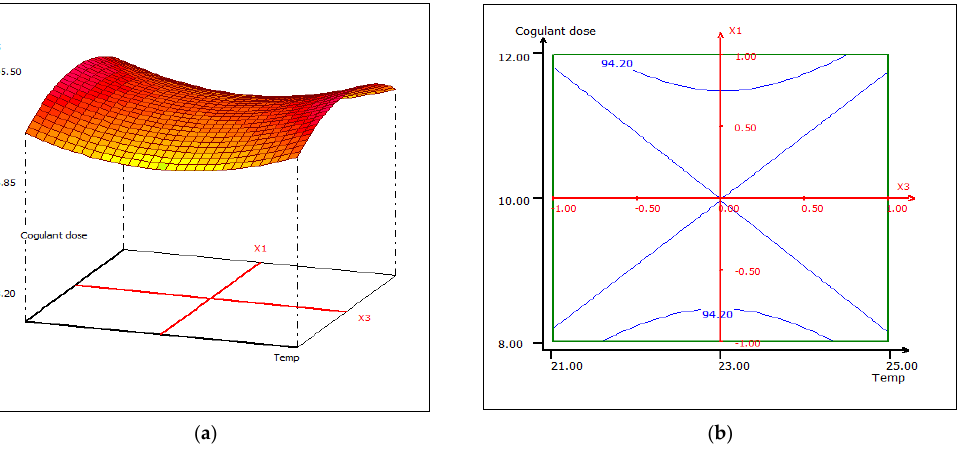
Figure 22. Three-dimensional ( a ) and two-dimensional ( b ) response surface plots for the BOD5 of the treated food wastewater using β-chitin extract as a function of coagulant dose and temperature, when the pH was maintained at 11.